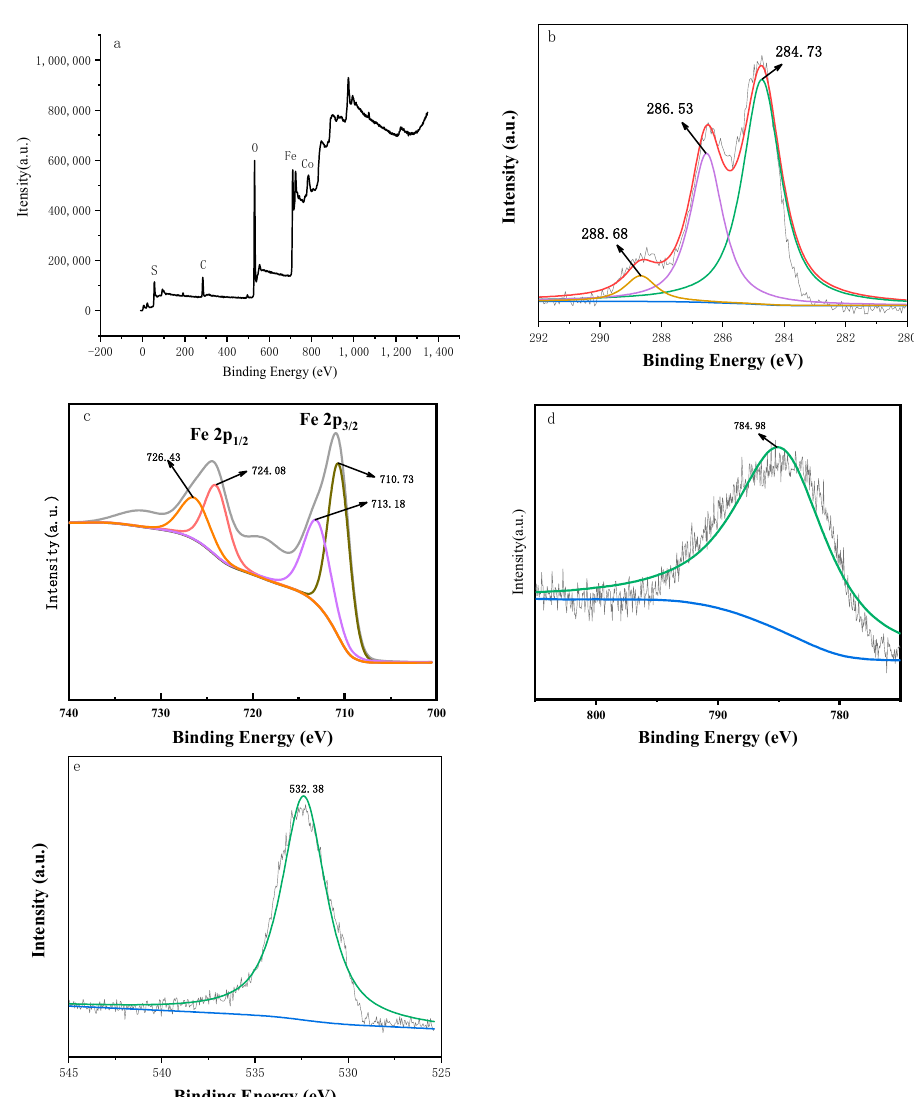
Figure 2. XPS spectra of Co-nZVI/GAC full scan ( a ), XPS spectrum of C in Co-nZVI/GAC ( b ), XPS spectrum of Fe in Co-nZVI/GAC ( c ), XPS spectrum of Co in Co-nZVI/GAC ( d ), XPS spectrum of O in Co-nZVI/GAC ( e ).